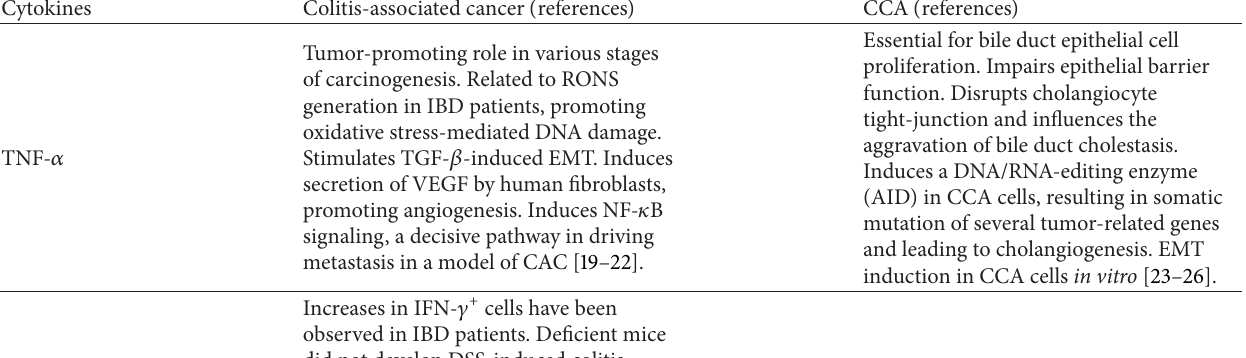
Table 2: Significance and role of cytokines in